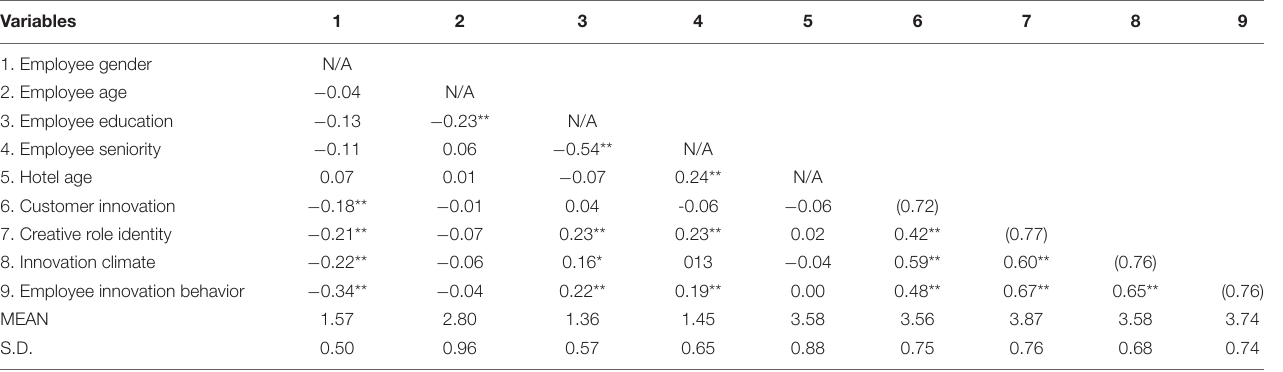
TABLE 3 | Means, standard deviations, and correlations.